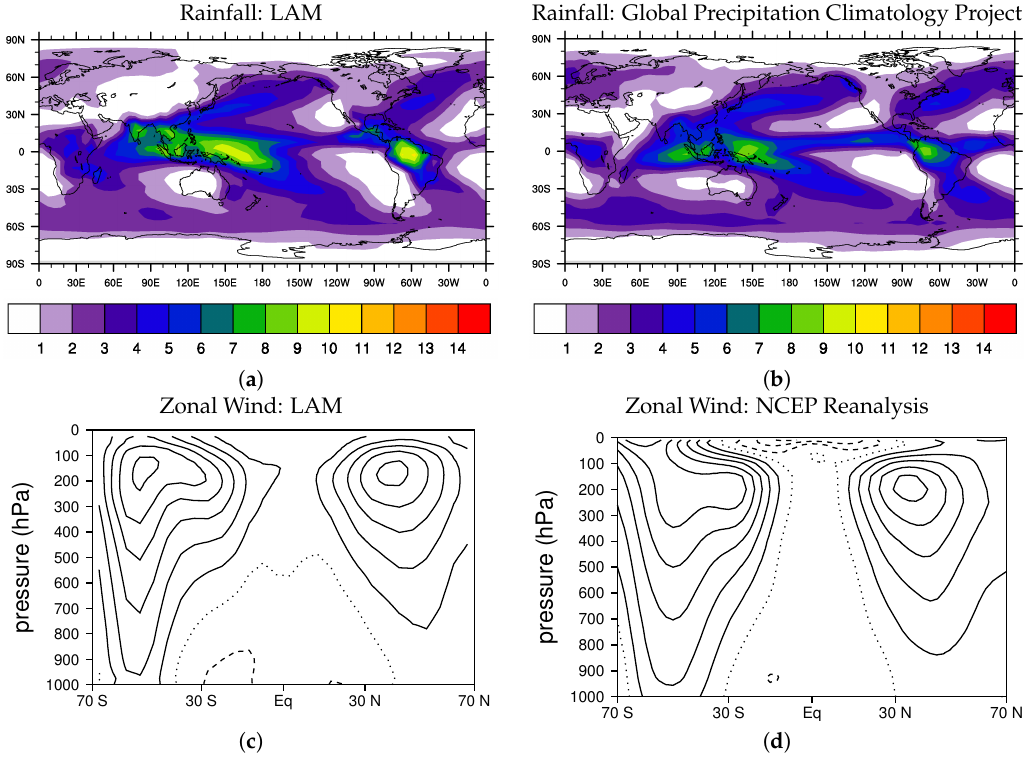
Figure 2. Annual average ( a , b ) rainfall and ( c , d ) zonal wind. Panels ( a , c ) show fields simulated with the Lagrangian Atmospheric Model, and panels ( b , d ) are based on observations. Rainfall is shaded with a 1 mm/day increment, and zonal wind is contoured with a 5 m/s interval with the zero contour dotted and negative contours dashed.